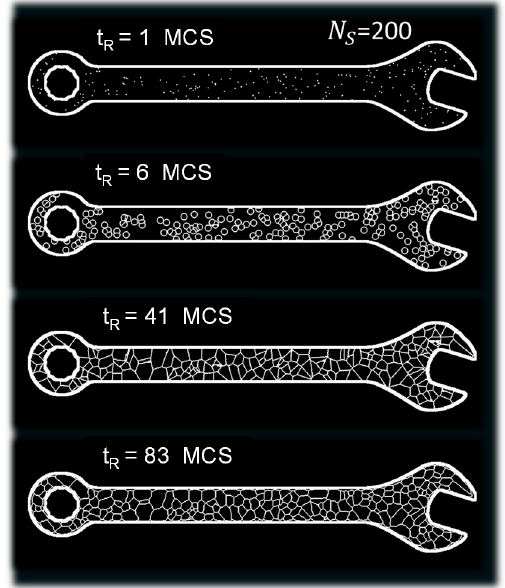
Figure 1. Evolution of the cellular structure within the design domain as a function of Monte Carlo steps for a fixed number of seeds ( N S = 200).